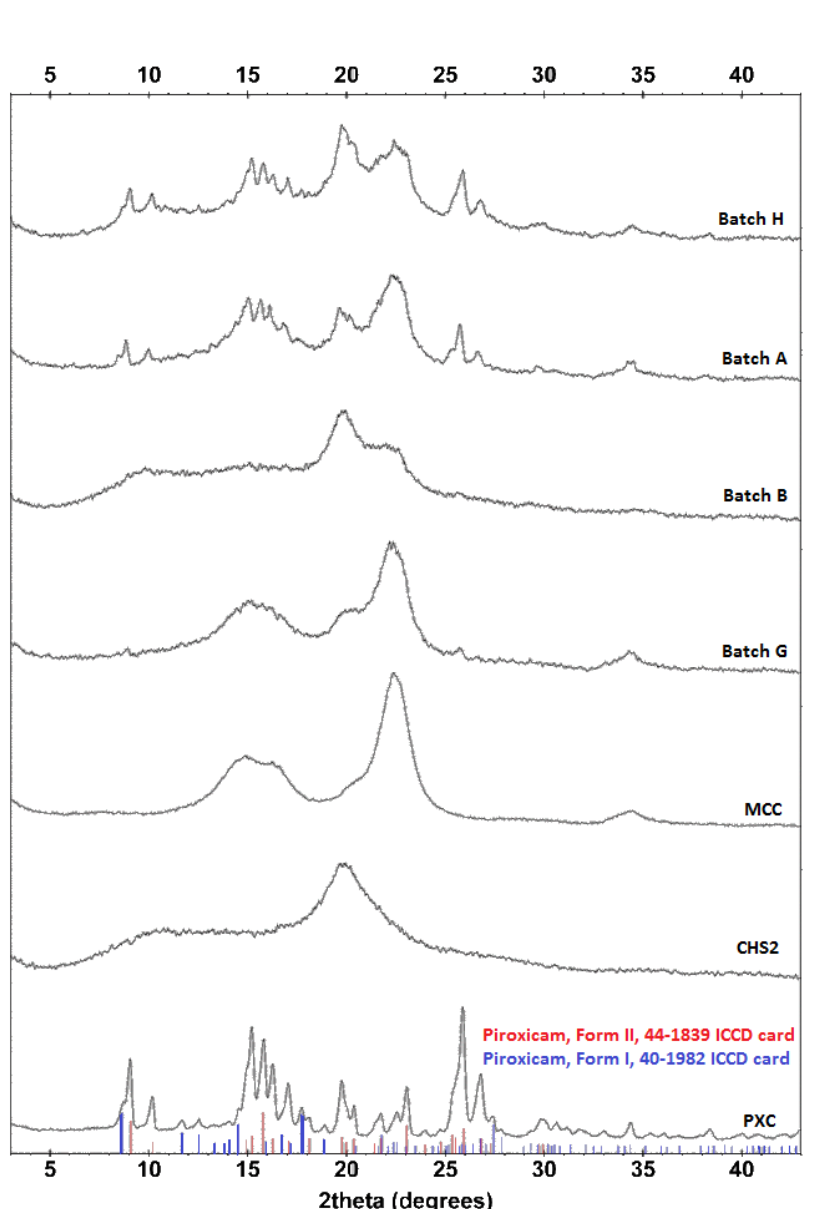
Figure 7. PXRDs for unprocessed materials and batches B and G with 5% drug content, and batches A and H with 21.25% drug content. Table 6. Crystallinity index (CI%) of the drug in the experimental pellet batches and the corresponding physical mixtures (PM). (Intensity of the drug at 25.8 2θ degrees 2132.55 a.u.). Batch Code/Drug% CI% of Drug in PM CI% of Drug in Pellet